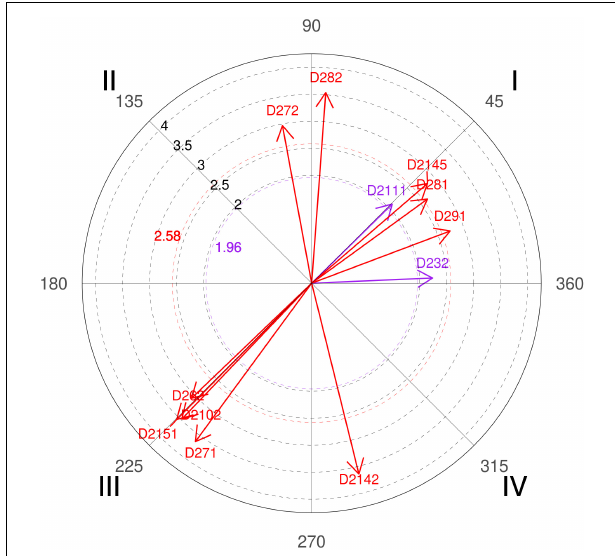
FIGURE 3 | Relationship of conditioned behaviors that present a significant relationship with the focal behavior “unfavorable evaluation” analyzing question 8 of the in-depth interviews. In “unfavorable evaluation,” a total of 12 significant vectors were